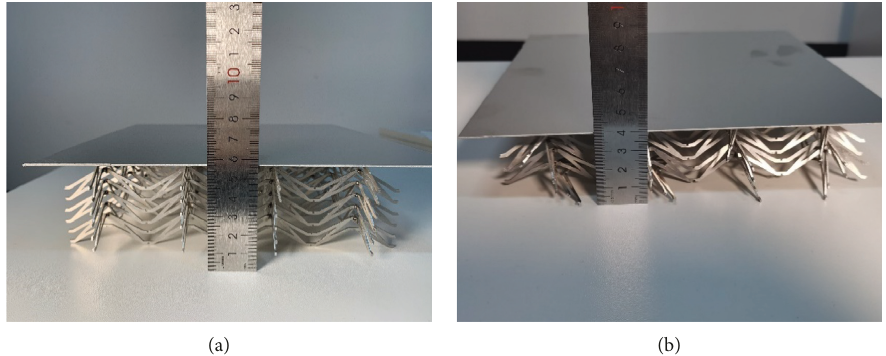
Figure 10: Sample 8 (a) before and (b) after low-speed impact